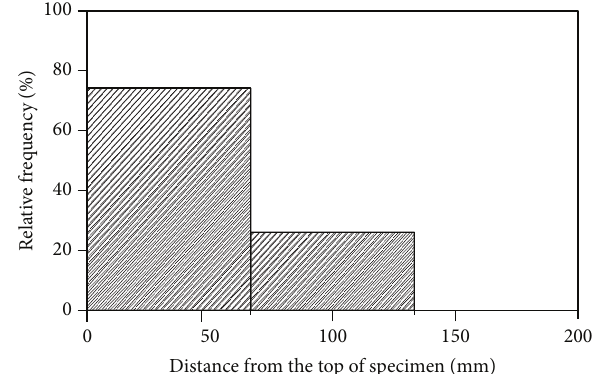
Figure 6: Cracking location measured from the top of specimen.